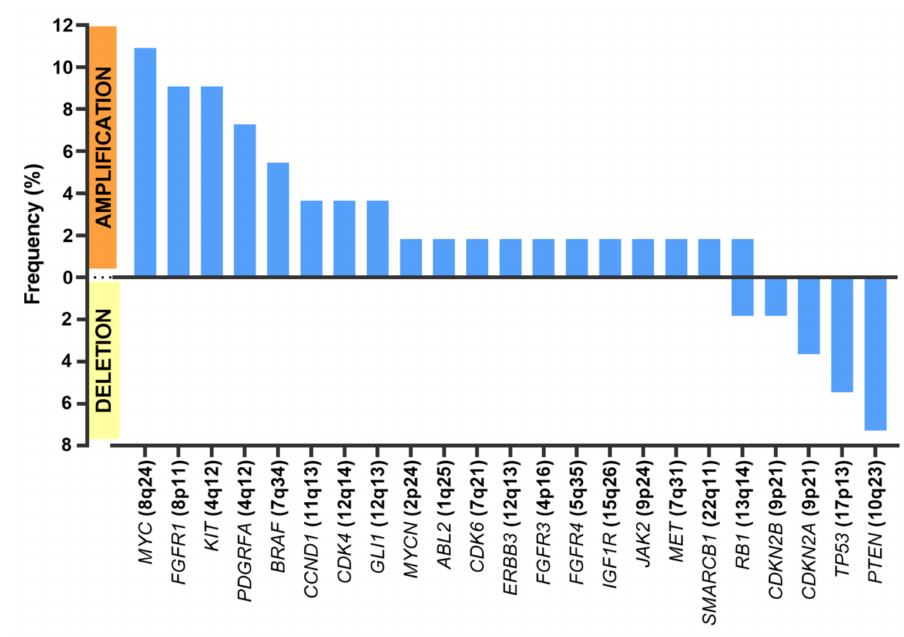
Figure 2. Frequent copy number alterations (CNAs).